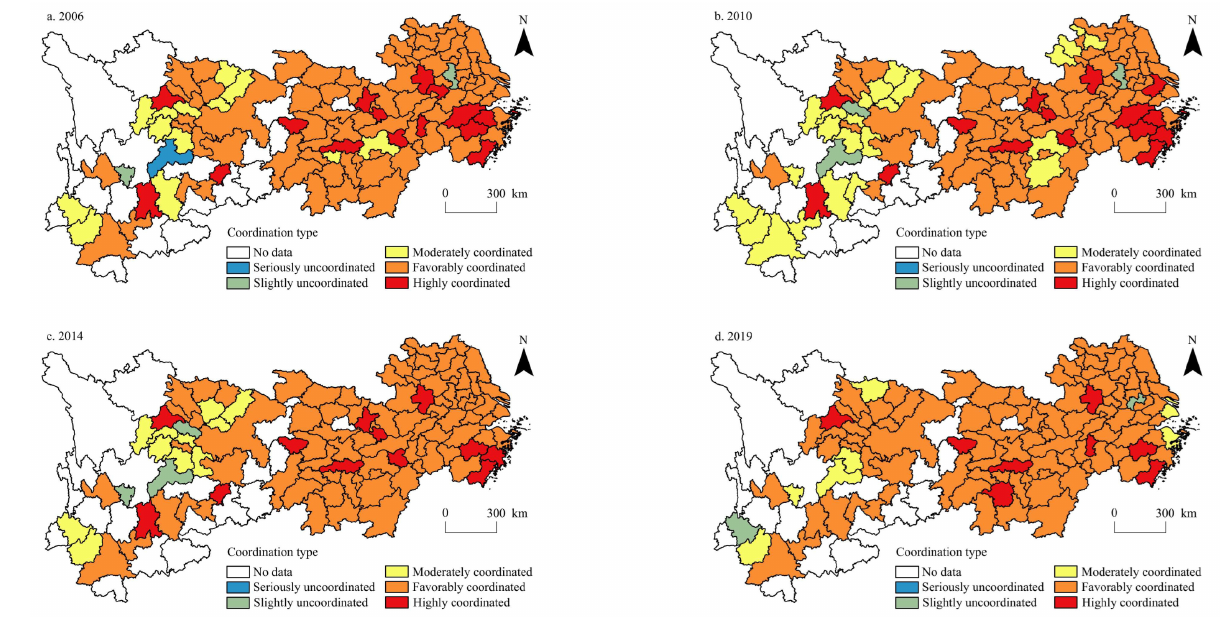
Figure 5. Spatial distribution of the type of coupled coordination between urbanisation level and per capita carbon emissions in the Yangtze River Economic Belt during 2006–2019.